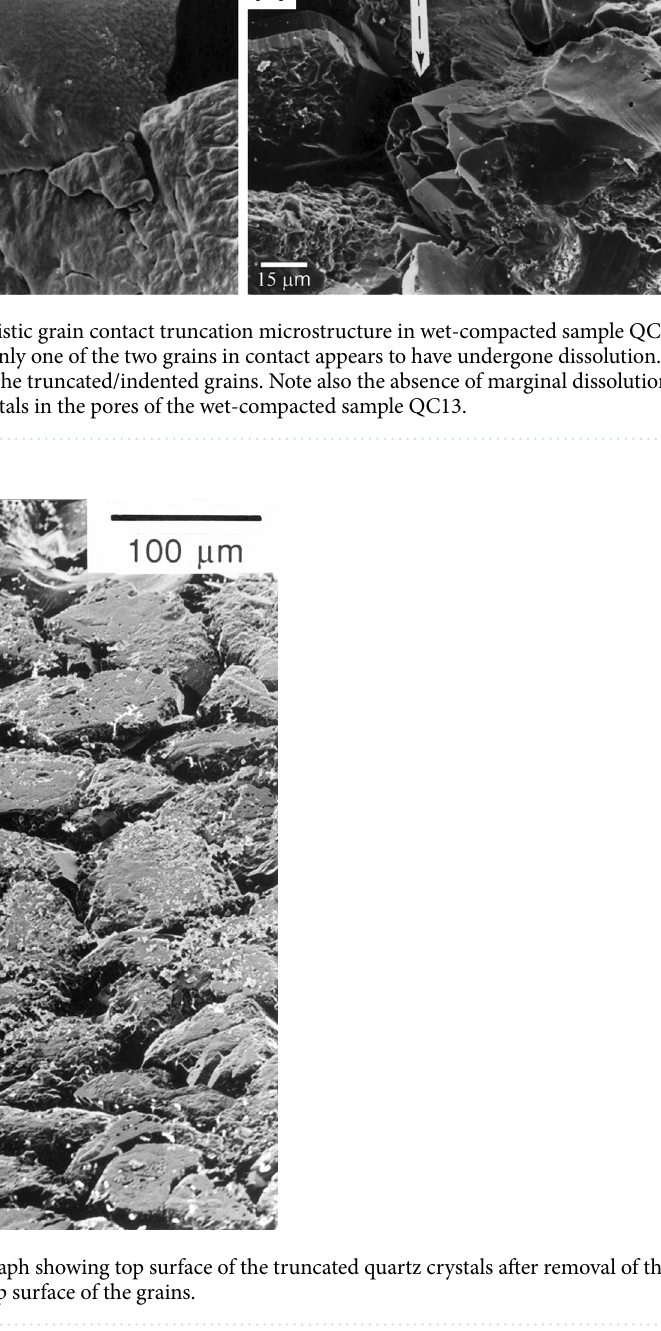
at the base of the sample (Fig. 3) but no pitting of quartz grains into the crystal was observed with the optical microscope. 1010 Surface microstructure of ( ) face. Figure 4a,b show SEM micrographs of the contact surface morphology of quartz grains which were pressed against the polished quartz crystal face. Note the conspicuous flat top surface (estimated roughness < 500 nm), confirming the impression gathered from optical microscopy of widespread truncation of the quartz grains against the polished ( 1010 ) face. The flat top faces display a wide variety of inclu- sions, varying in shape from triangular and inverse-pyramidal (Fig. 4a) to sub-rounded (Fig. 4b), and ranging in size from several hundred nanometers to about 3–4 µm. The intervening regions between the inclusions appear to be flat within SEM resolution, which implies that the surface relief (if any) in these regions is smaller than about 10 nm. SEM observations confirmed that pits into the polished crystal surface are virtually absent. The few pits that were seen with the SEM are oval-shaped and have a long dimension in the range 3 to 10 µm